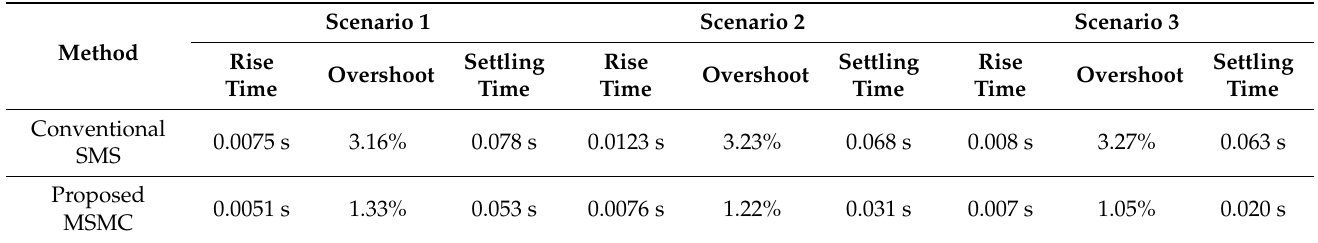
Table 4. Performance comparison of studied method for reactive